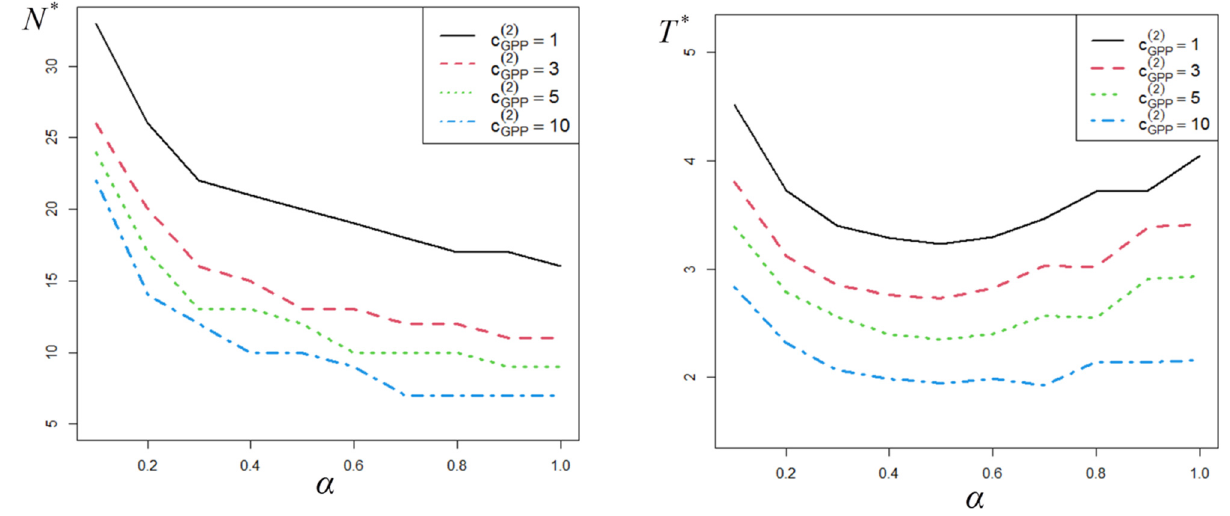
Figure 1. Optimal values N ∗ and T ∗ for different values of α and c ( 1 ) = 3 (fixed). c GPP